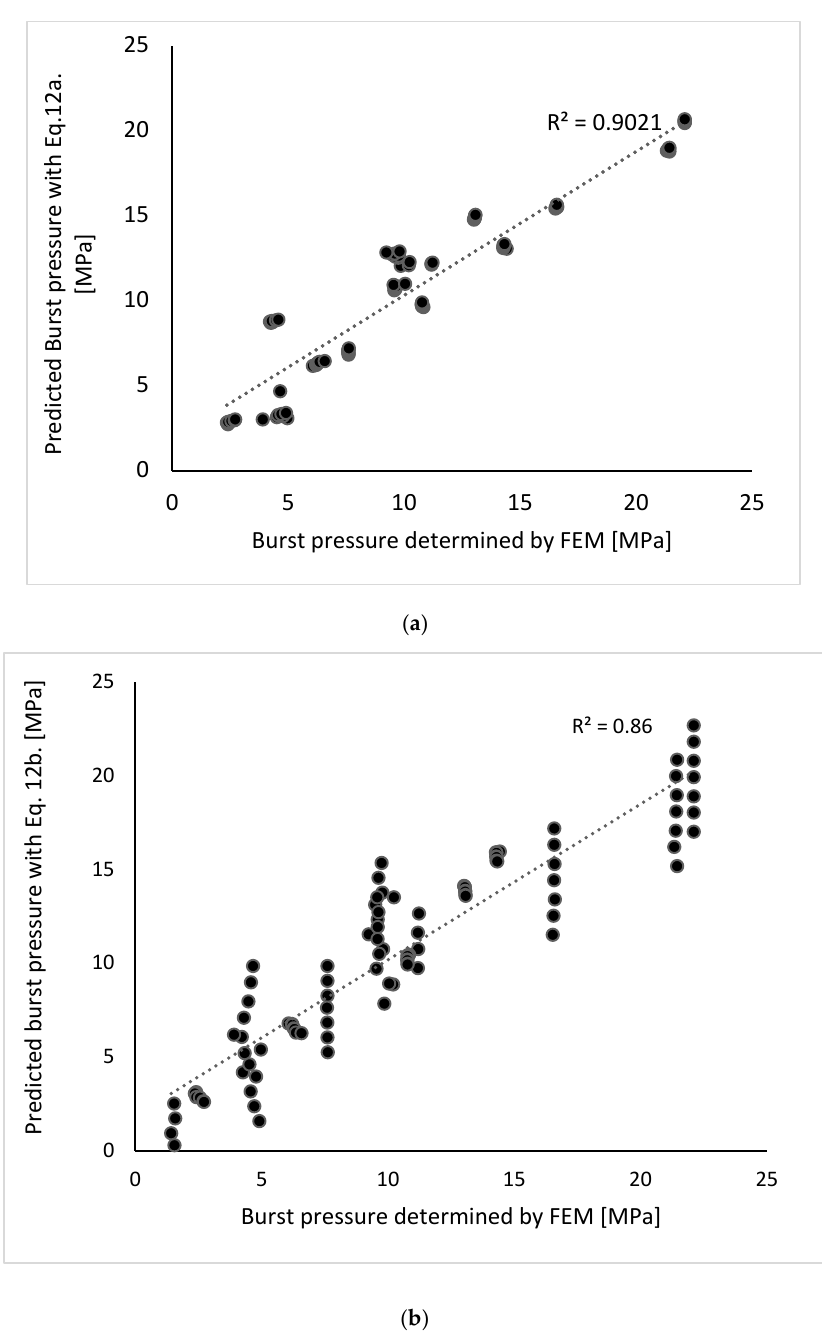
Figure 7. ( a ) Comparison of the FEM estimation ( P b ) with the estimation from Equation (12a). ( b ) Comparison of the FEM estimation ( P b ) with the estimation from Equation (12b).